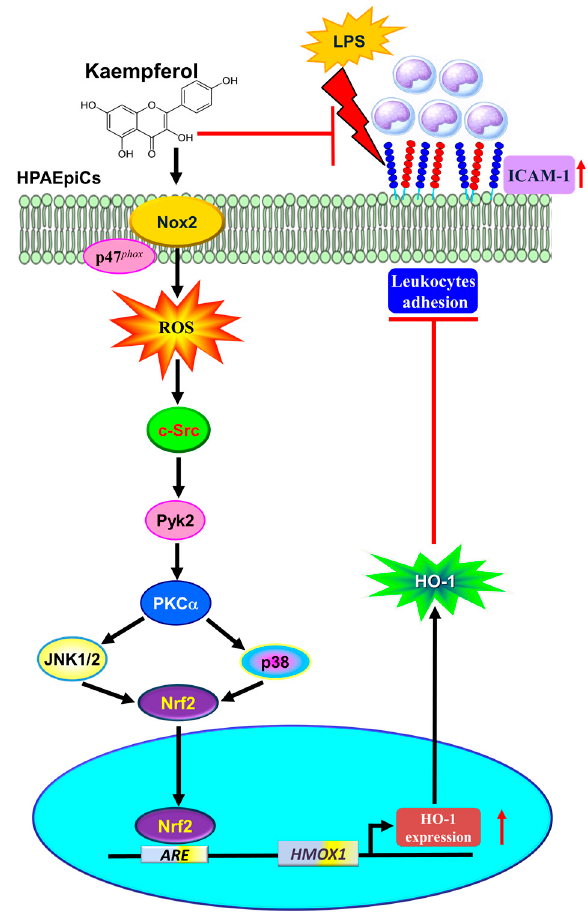
Figure 11. A schematic pathway for KPR-induced HO-1 expression in HPAEpiCs. KPR attenuated LPS-induced ICAM-1 expression and lung monocyte/leukocyte accumulation through upregulation of HO-1 via enhanced p47 phox /Nox2 activity, resulting in the accumulation of intracellular ROS. Imbalance in oxidative stress promoted the phosphorylation of c-Src/Pyk2/PKC α /p38 α MAPK- and JNK1/2-dependent Nrf2 activation, which further binds with ARE on HO-1 promoter and suppresses the LPS-mediated inflammation in HPAEpiCs and in vivo. Thus, upregulation of the HO-1 by KPR exerts a potential strategy to protect against pulmonary